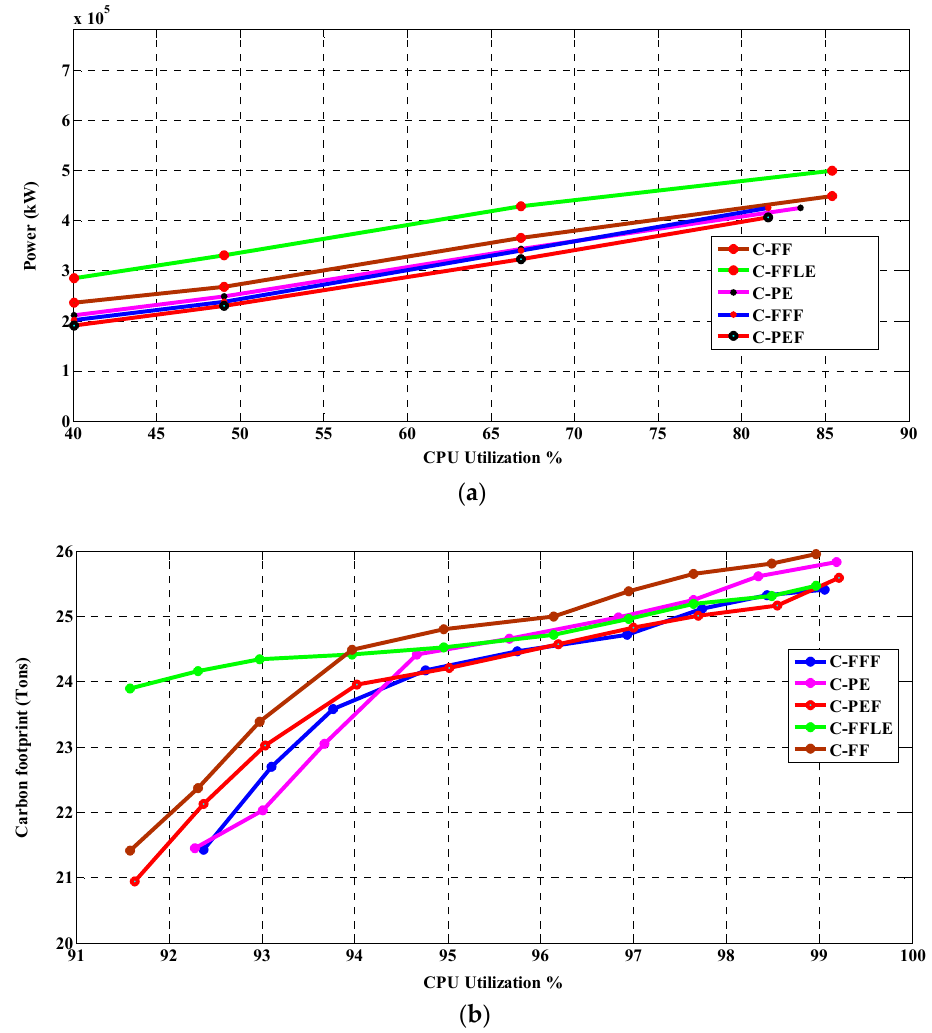
Figure 8. ( a ) Power consumption values with low utilization. ( b ) Carbon footprint values with high